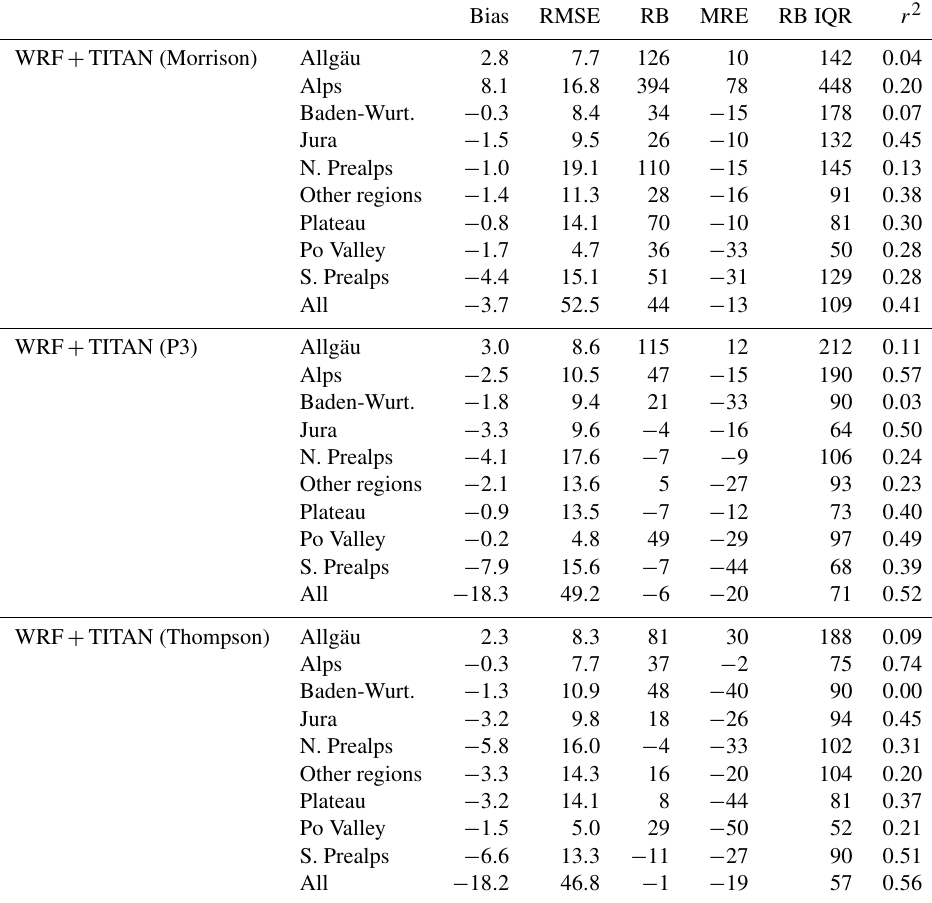
Table 5. Performance statistics on cells detected per day per region, with TRT (observations) taken as the reference. Statistics shown are bias [d − 1 ], root mean squared error (RMSE) [d − 1 ], relative bias (RB) [%], median relative error (MRE) [%], interquartile range of relative error (RE IQR) [% points], and squared Pearson correlation ( r 2 ) [–].